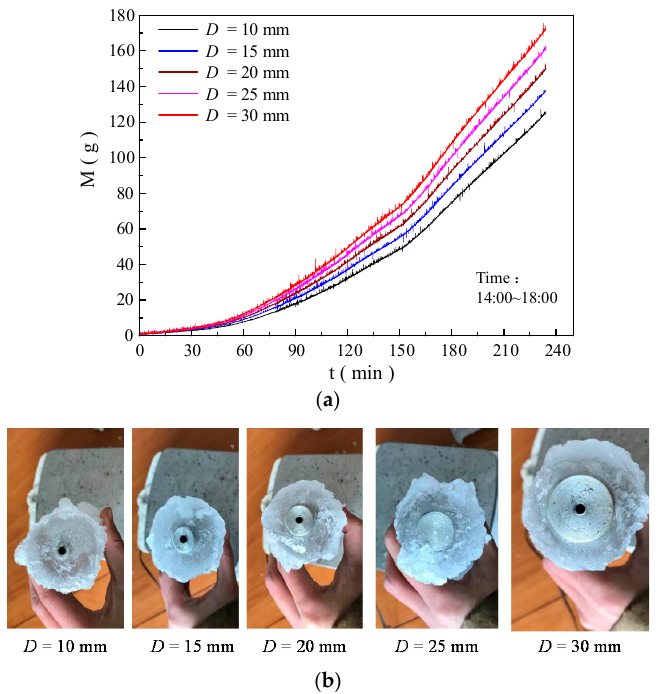
Figure 8. Icing ( a ) mass and ( b ) shape of five cylinders.